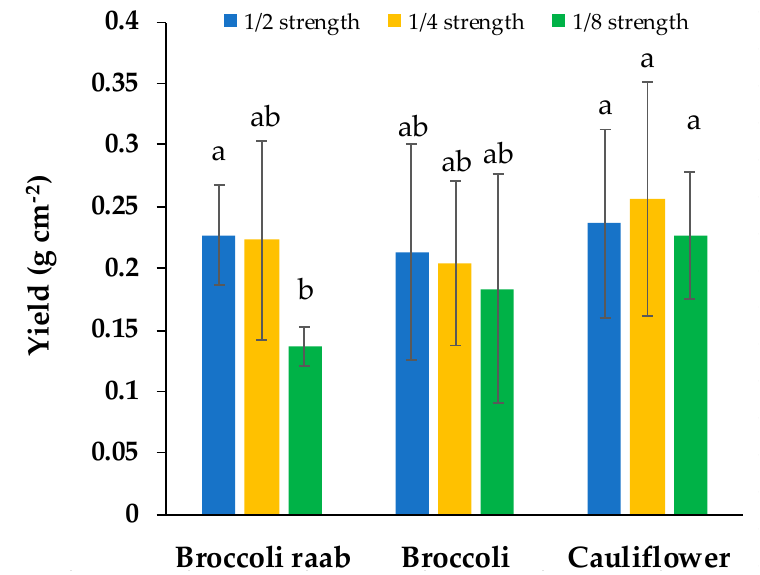
Figure 2. Yield of three genotypes of microgreens grown with three NS strengths: 1/2 strength, 1/4 strength and 1/8 strength (first experiment). Different letters indicate that mean values are significantly different, according to the SNK test ( p = 0.05). Vertical bars represent ± standard deviation of mean values.